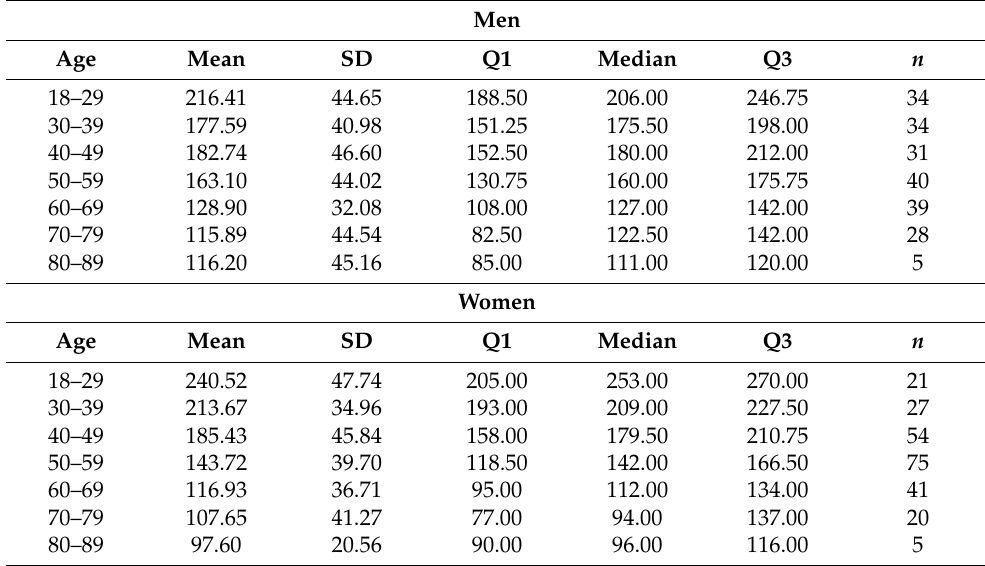
Table 4. L1 trabecular attenuation (HU) in bone window for men ( n = 211) and women ( n = 243) grouped by